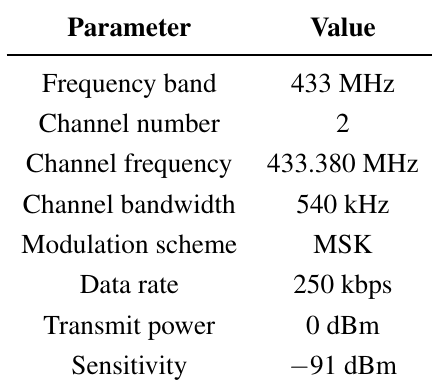
Table 1. Physical layer parameters according to the IEEE 802.15.4f